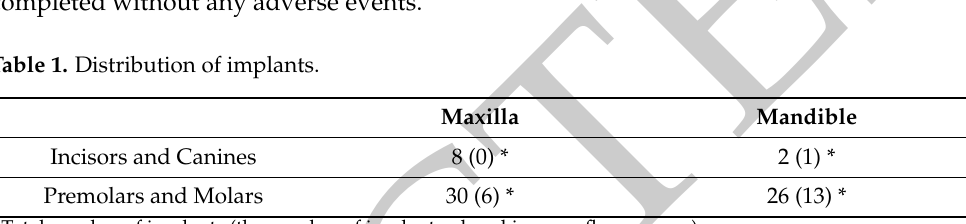
Maxilla Mandible